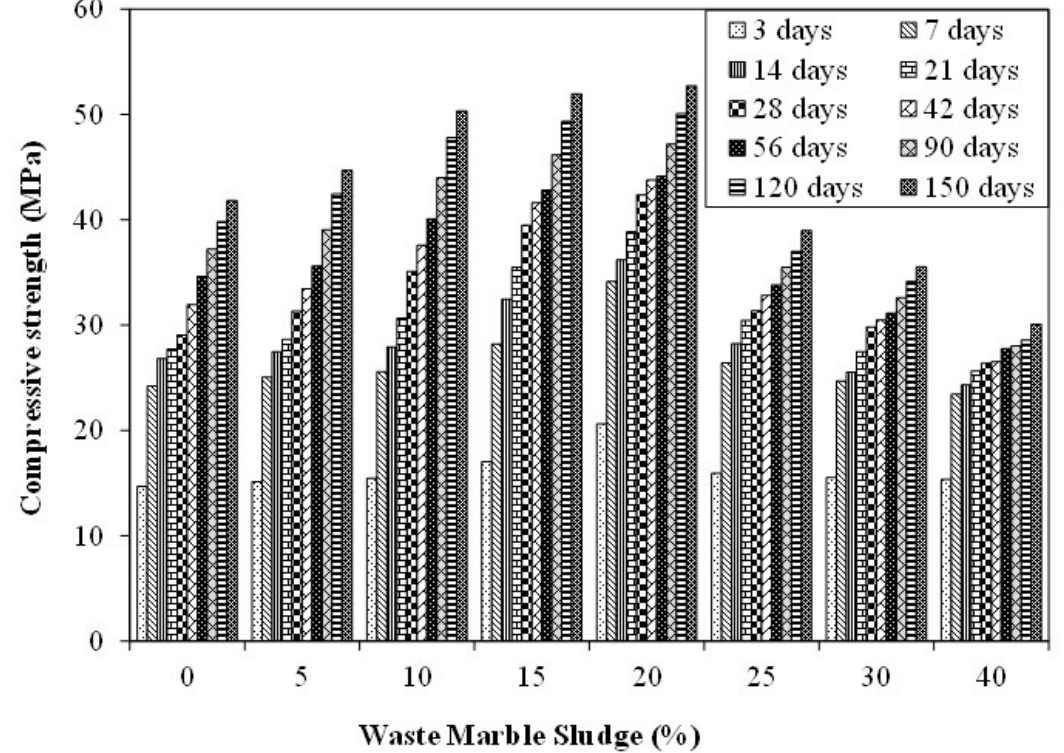
Figure 4. Compressive strength results.